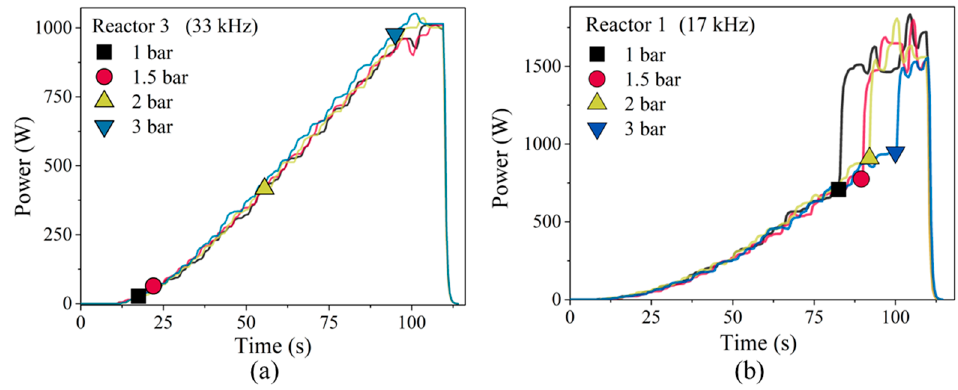
Figure 5. The cavitation onset at various external pressures with a gradual increase in the power of the ultrasonic transducer in ( a ) Reactor 3, and ( b ) in Reactor 1, at ambient temperature.